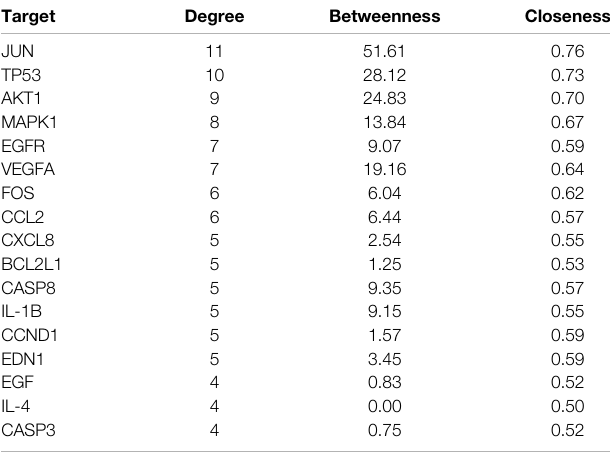
TABLE 4 | The topological parameters of hub targets. Target